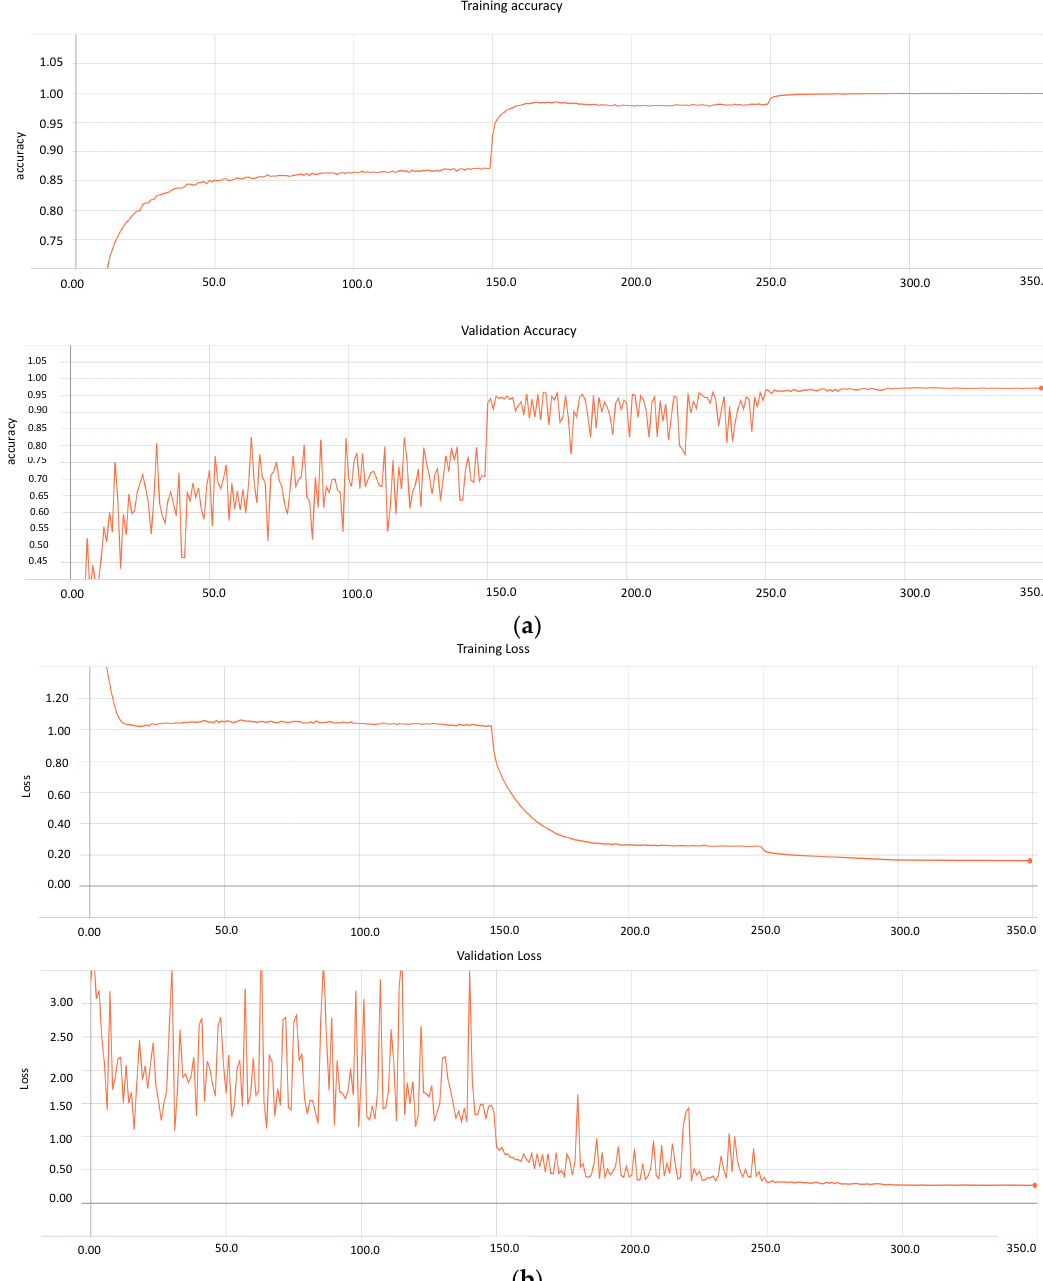
Figure 5. (a) Represents the accuracy of model for training and validation. Our deep and densely connected model runs for 350 epochs. (b) Represents the loss of model for training and validation process. It shows how loss of model reduces across epochs.